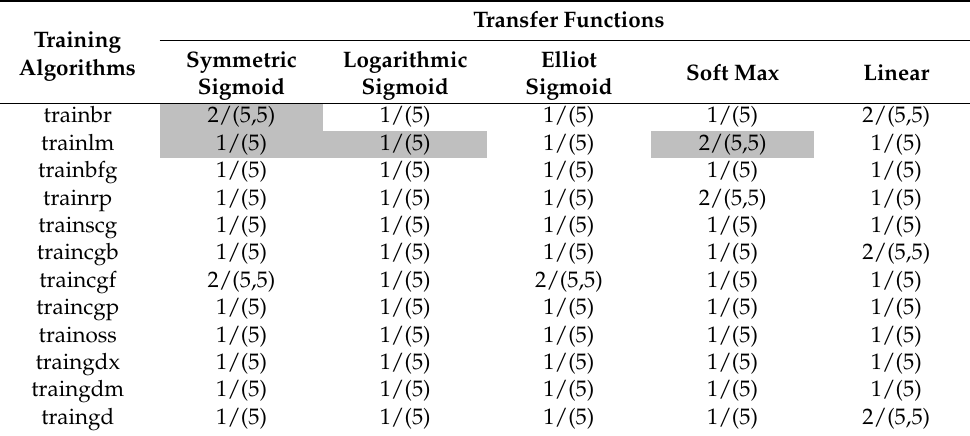
Figure 13. Prediction efficiency in percentage for each tested case. Table 5. The number of hidden layers and the number of neurons for each hidden layer in the form “h/(n1, n2)”, where h is the number of hidden layers and n1 and n2 are the number of neurons for the first and second layer. Grey shade indicates the highest prediction efficiencies.